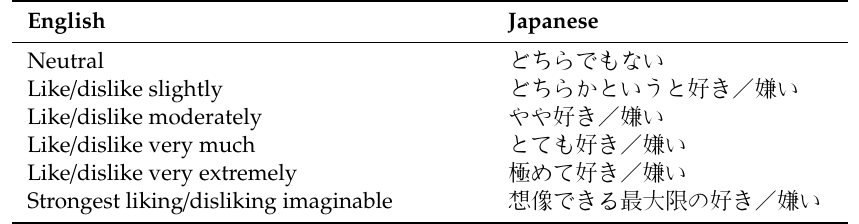
Table A2. Ratings of liking / disliking of sweet-tasting foods (mu ffi n, sweet yogurt and banana).